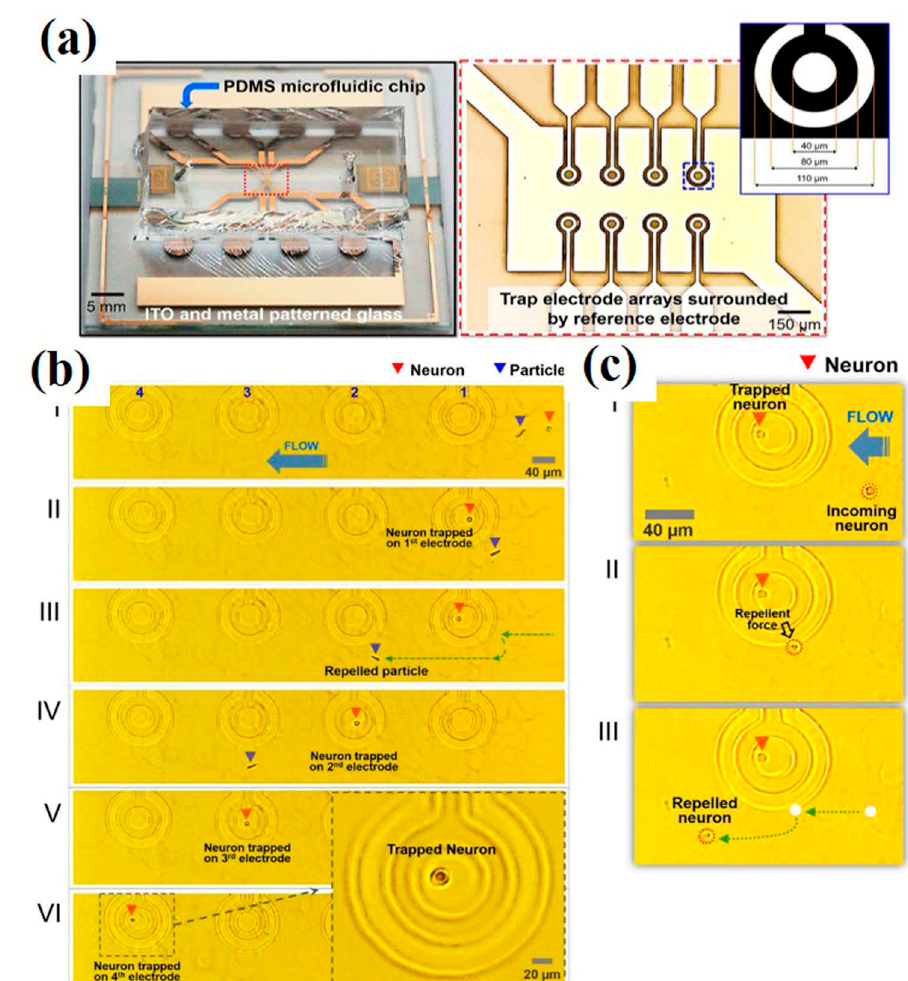
Figure 20. ( a ) Image of the microfabricated device and bright-field microscopic image of the electrode array. ( b ) Recorded images of single-neuronal cell manipulation on the array of ring-shaped traps. Incoming neuron ( I ) entering the 1st trap. ( II ) The neuron gets immobilized in the 1st trap electrode against a fluid flow. ( III ) When a neuron is trapped, the repelled particle keeps on moving in the flow of media. ( IV ) The released neuron gets trapped in the 2nd trap. ( V and VI ) The neuron is trapped in the 3rd and the 4th ring trap in turn. ( c ) The images show bouncing motion of the neuron subjected to a repulsive force. When the target neuron gets trapped in the desired electrode, the incoming neuron faces repulsion due to DEP force. At the end, when the incoming neuron reaches the outside of the electrode, the repulsive force pushed the neuron out of the ring. Reprinted with permission from [58].